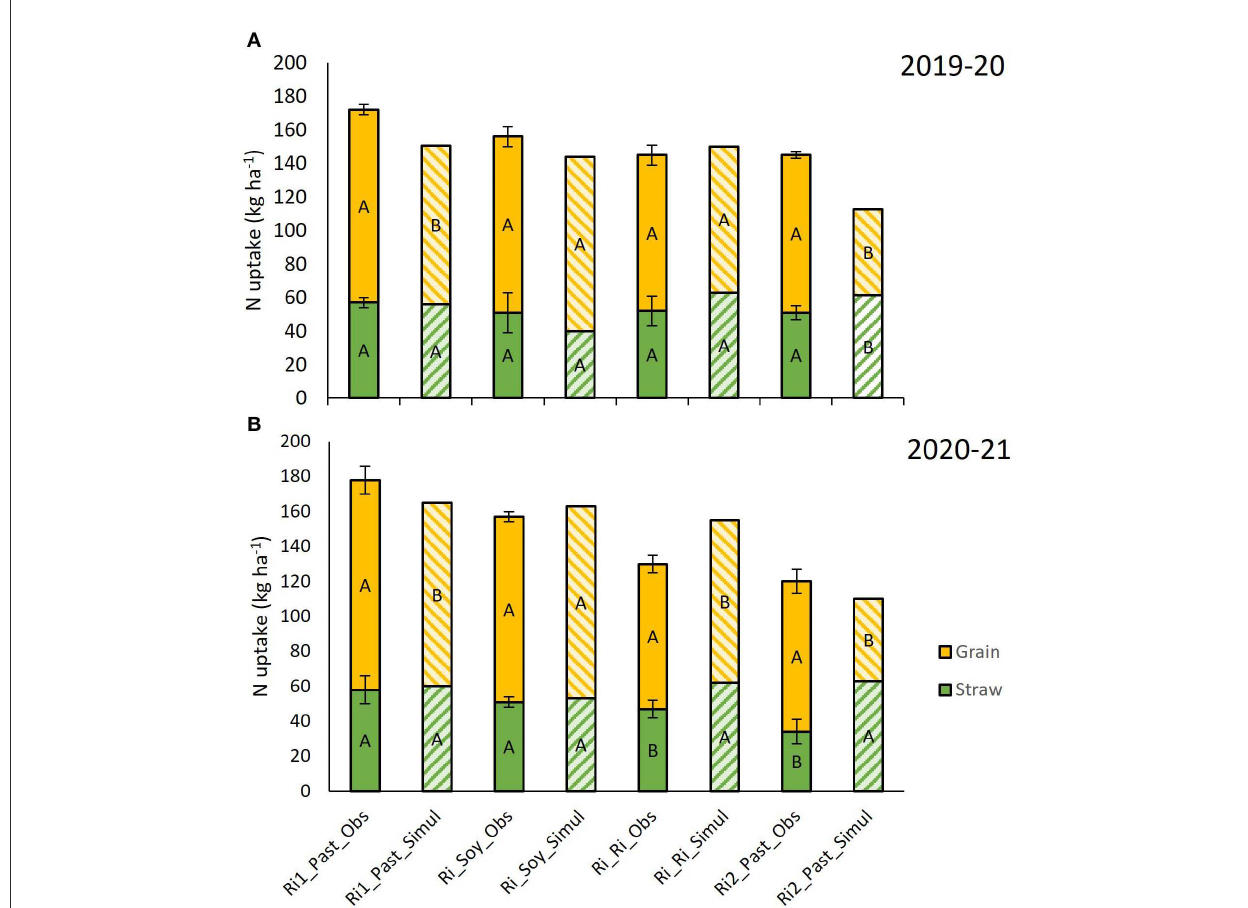
FIGURE3 Comparison of simulated and observed rice grain and straw N uptake (kg N ha − 1 ) at physiological maturity in the rice-pasture (first and second rice), rice-soybean and continuous rice in (A) 2019–2020 and (B) 2020–2021 growing seasons. Observed data are means ± standard errors ( n = 3). Letters next to bars indicate differences (Fisher 5%) between simulated and observed grain and straw N values for each